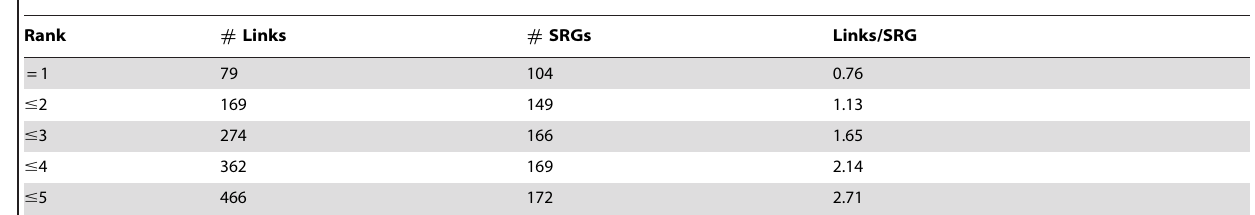
Table 3. Numbers of study section pairs by consensus